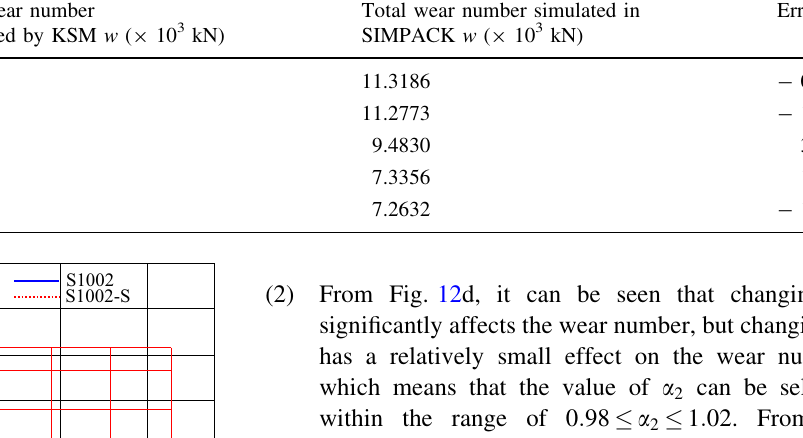
Fig. 12 Input sample variables ( a ), output sample responses ( b ), the corresponding KSM model ( c ), and the optimal result solved by PSO ( d ) Table 2 Comparison between the results calculated by KSM and the results simulated in SIMPACK Correction factor a